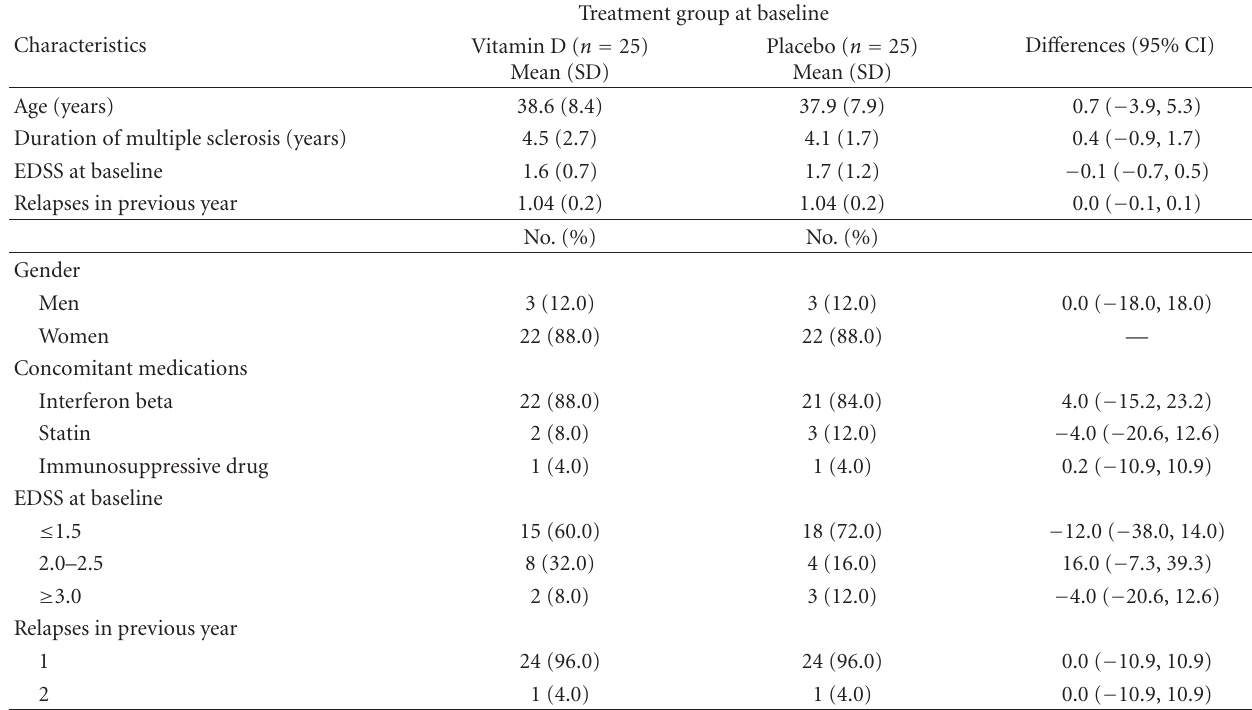
Table 1: Characteristics of patients with relapsing-remitting multiple sclerosis who received low-dose vitamin D (0.5 µ g/day) or placebo at baseline.